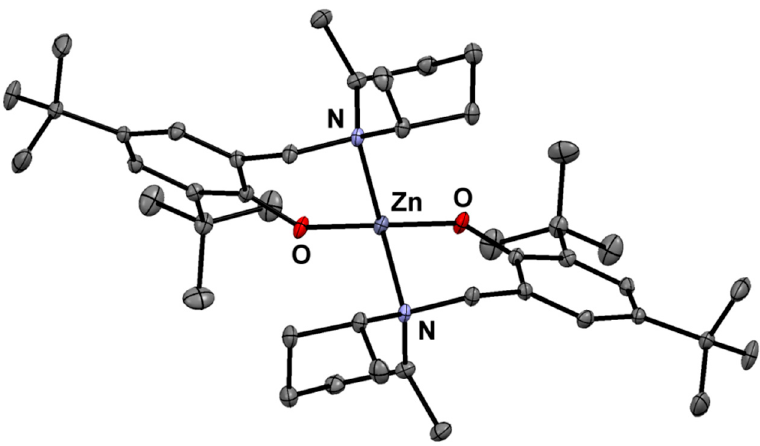
Figure 1. Molecular structure of (L dmp ) 2 Zn.